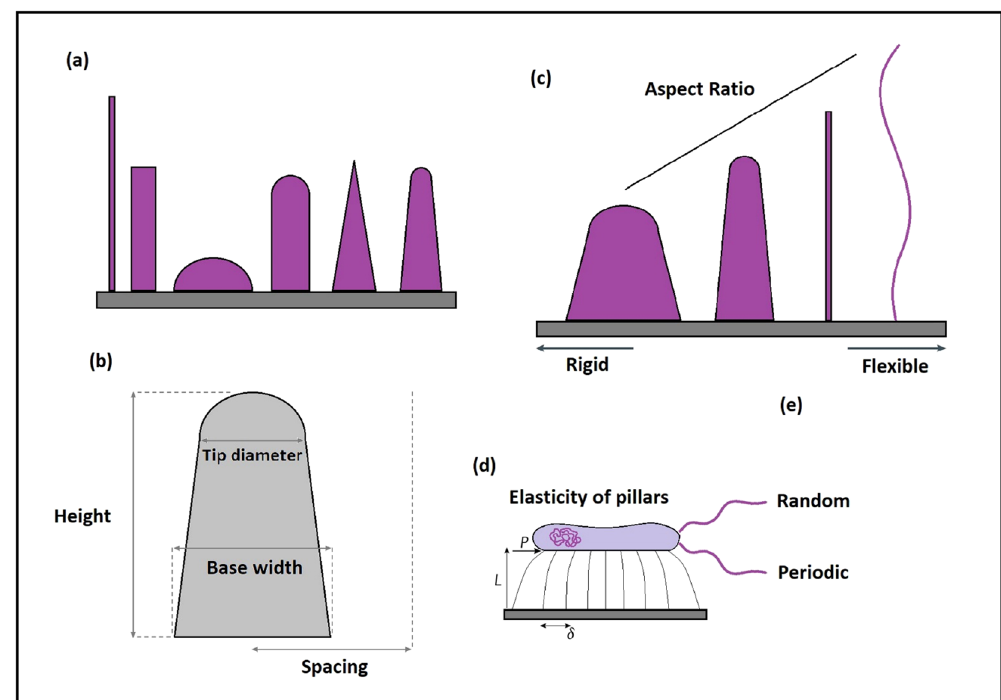
Figure 17: Schematic illustration of the physical parameters a ff ecting the mechano - bactericidal activity of nanopillars and their derivations. ( a ) Examples of di ff erent nanopatterns with varied biocide levels. ( b ) The geometric characteristics are simpli fi ed based on the spacing, base diameter, tip diameter, and height. ( c ) Increasing the aspect ratio changes the rigid nanopillar to a fl exible one, and subsequently, is accompanied by di ff erent cellular and antibacterial responses. ( d ) According to the aforementioned parameters, the strength of each individual nanopattern to impose physical forces on the cell membrane is related to the geometries. ( e ) Fabrication of nanopatterns can be either in random or periodic arrays. Therefore, the optimized mechano - bactericidal function demands signi fi cant attention to the geometric parameters and cautious fabrication.